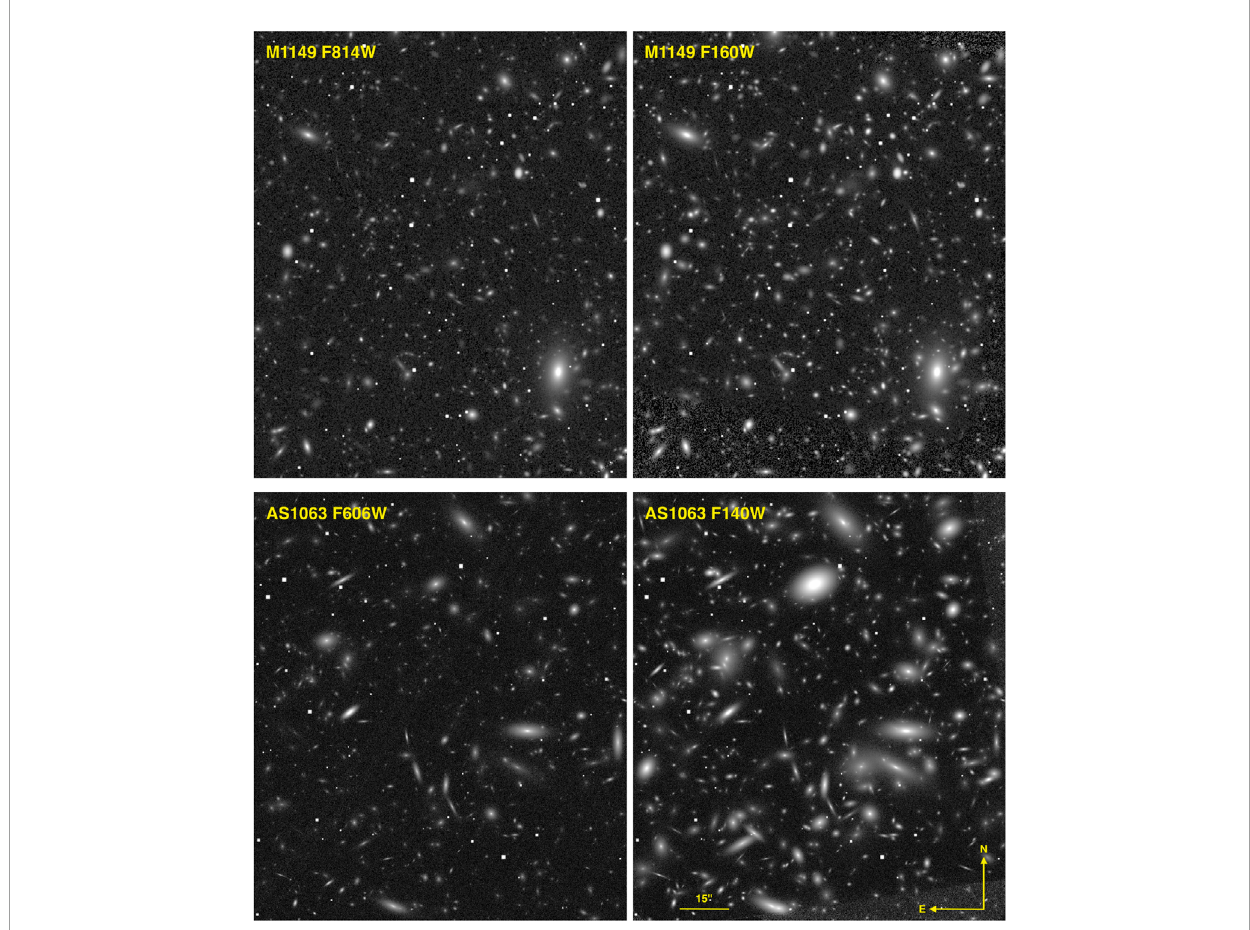
FIGURE 4 This figure shows the simulated HST Frontier Fields images ( 2000×2,300 pixels) for the clusters M1149 (upper panels) and AS1063 (lower panels). The M1149 simulations are shown in the F814W (upper left panel) and F160W wavebands (upper right panel). Galaxies in this cluster are rendered as single Sérsic profiles. The AS1063 simulations are shown in the F606W (bottom left panel) and F140W wavebands (bottom right panel). Galaxies in this cluster are rendered as bulge plus disk components with different B/T ratios. The simulated images have been created matching the background noise and the PSF FWHM of the real Frontier Fields observations. The matching noise features coming from the real rms images are visible for instance in the bottom and upper right corner of the lower right image. The images orientation and scale are the same, and are highlighted in the lower right figure.